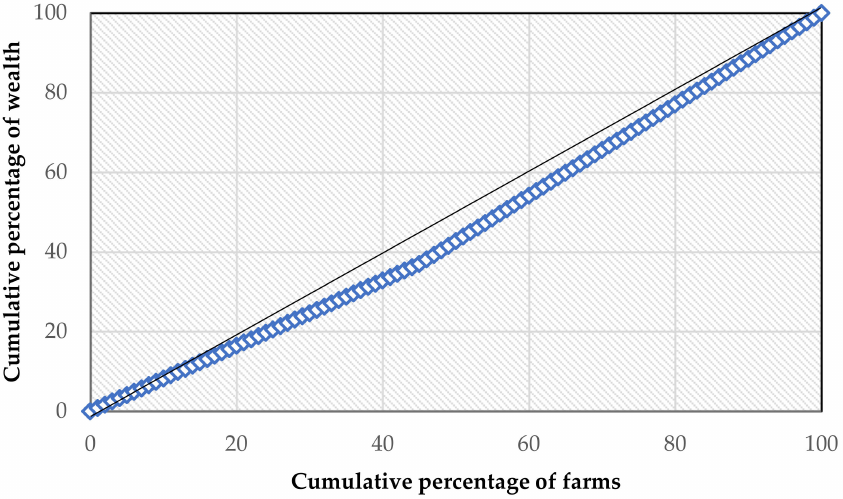
Figure 5. Lorenz curve for average values after penalisation and reallocation of reduced over- consumed water quantities. Source: Own elaboration based on model results